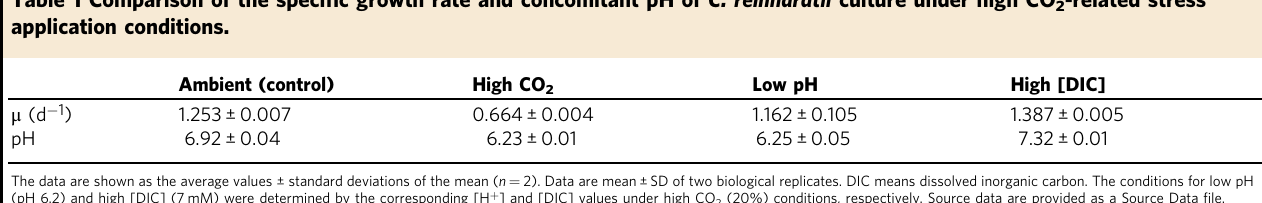
Fig. 1 Transcriptome landscapes of the CO 2 intolerant algal species C. reinhardtii (WT) exposed to extremely high CO 2 (20%) and low pH (pH 5.0) conditions. a Growth of the WT strain under high CO 2 and low pH conditions. The conditions for EC 50 were selected (Supplementary Fig. 1). The arrow indicates the time point of biomass sampling for RNA-seq ( n = 3). Data are the mean ± SD of three biological replicates. b Scatter plot of the expression levels of each gene (in RPKM values). A pseudocount was added to all RPKM values to enable plotting. The transcriptional changes in the PMA2 and PMA3 genes are highlighted by black circles and triangles, respectively. c Venn diagrams of the number of genes that were commonly upregulated (log 2 Fold change (FC) > 1, p < 0.05) or downregulated (log 2 FC < 1, p < 0.05) under excess proton-derived stress conditions compared with their expression in cells grown under ambient conditions (as a control). The areas are to scale. d The left panel shows the predicted cellular responses to excess proton- derived stresses, and the right boxes present a heatmap of the log 2 FC values of the cell ’ s knowledge-based selected genes. The detailed roles and descriptions of the genes under CO 2 -enriched conditions are described in Supplementary Data 3. An asterisk in the boxes indicates a statistically signi fi cant difference ( p < 0.05) compared with the expression level under ambient conditions. An asterisk is shown only for the transcriptomes that showed over 2-fold changes in expression. In c and d , the statistically signi fi cant differences were determined by the generalized linear model (GLM) likelihood ratio (LR) test. Source data are provided as a Source Data fi le.